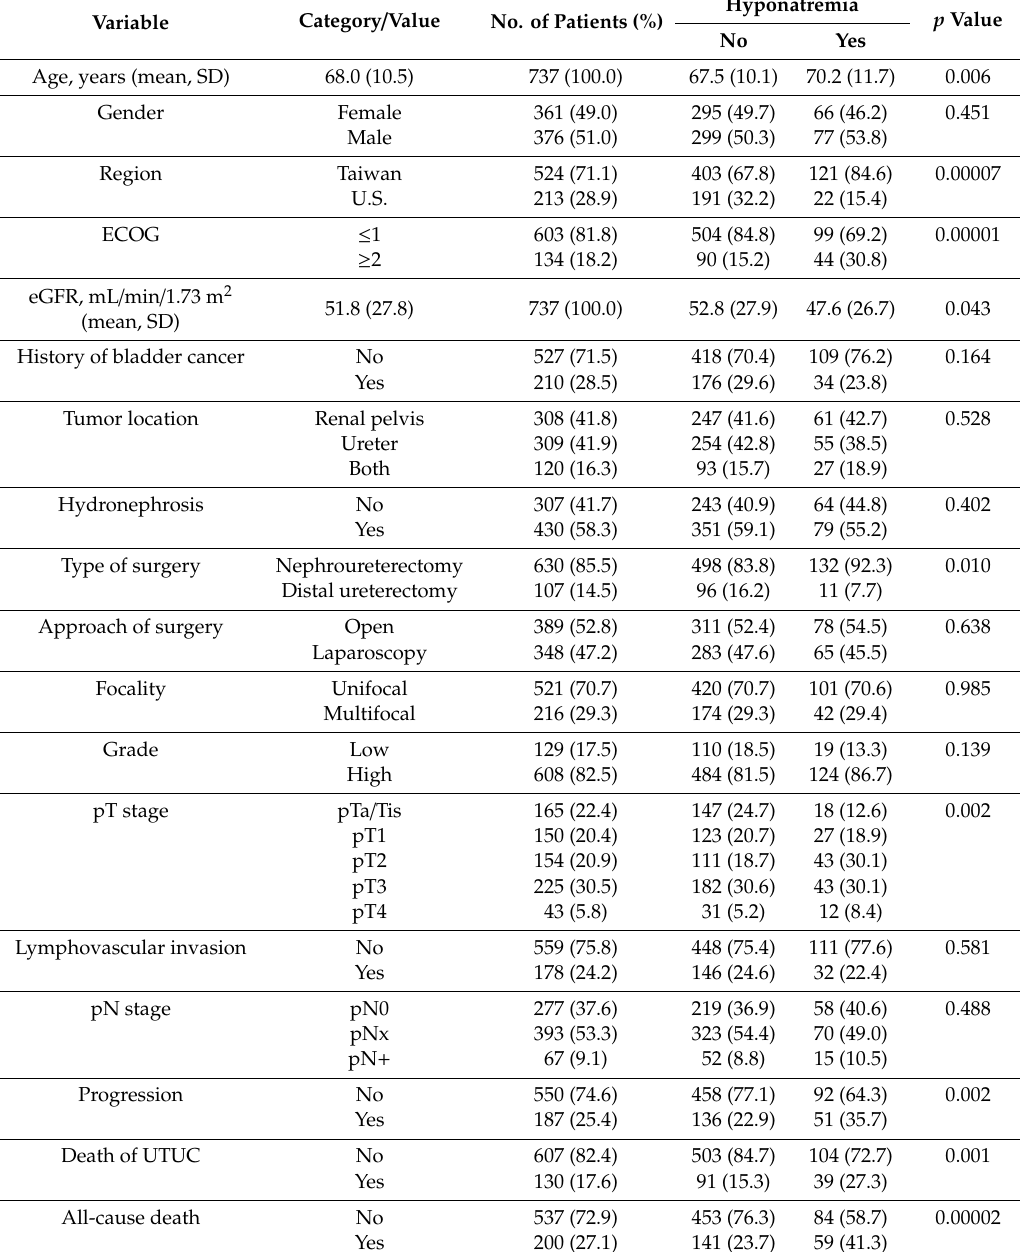
Table 1. Association of hyponatremia with patients’ clinicopathologic